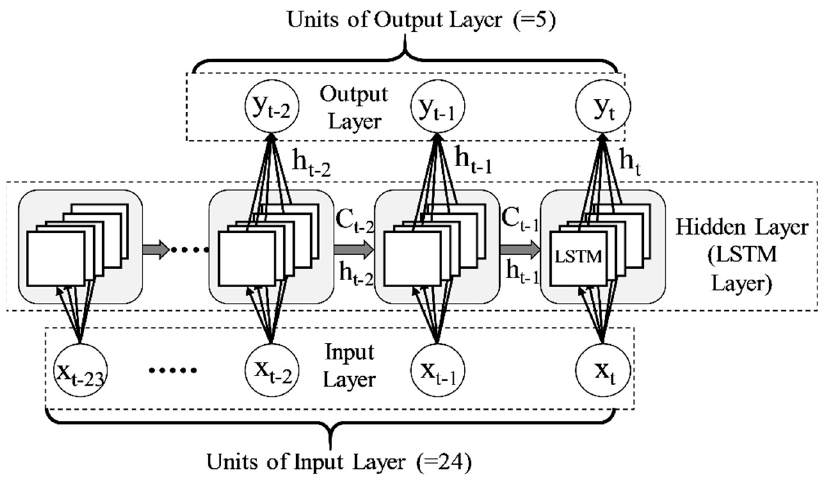
Figure 2. Structure of LSTM model.